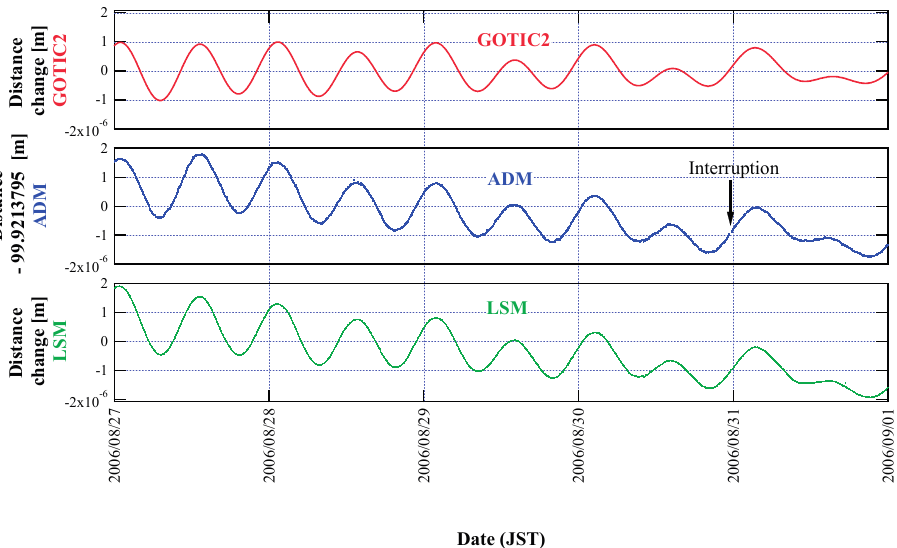
Figure 6. Ground strain measured with the ADM. LSM, laser